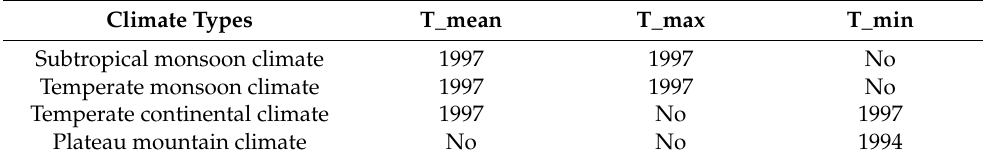
Figure 4. Mann-Kendall tests of daily ERA-Interim temperature data for the four different climate zones within Gansu Province during the period 1979 ‒ 2017. ( a ) Mean temperature. ( b ) Maximum temperature. ( c ) Minimum temperature. Table 4. Mutation time of annual mean temperature for the four different climate zones within Gansu Province during the period 1979–2017 ( ◦